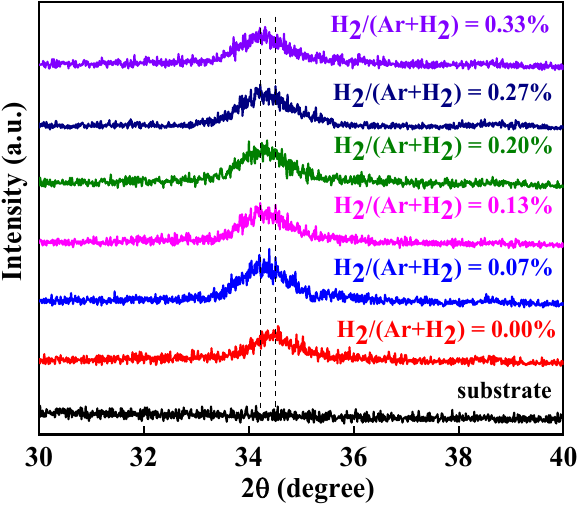
Figure 3. GIXRD curves of ZnO:H/ZnO films prepared with different H 2 /(Ar + H 2 ). To analyze the effect of H doping on oxygen-related defects in ZnO films, the O 1s energy spectra of ZnO:H films with different H 2 /(Ar + H 2 ) were obtained by XPS measurement and are shown in Figure 4. The O 1s energy spectra were calibrated by using 285 eV C 1s binding energy as the standard in order to compare the measured O 1s binding energy with the data from the NIST database and other references. As exhibited in Figure 4a–f, the fitting results consist of three components of oxygen in varying chemical states [24–27]. The fitting peak at 529.8 ± 0.2 eV is related to the O 2 − in metal oxide, representing the lattice oxygen existing in the Zn-O bonds, marked as O 1 . The fitting peak at 530.7 ± 0.2 eV is associated with O 2 − ions in the oxygen-deficient regions within the matrix of ZnO, and the peak intensity reflects the change of oxygen vacancy (V O ) content, marked as O 2 . The fitting peak at 531.9 ± 0.2 eV is attributed to the loosely bound oxygen in ZnO, including oxygen interstitials (O i ) and adsorbed oxygen [28], marked as O 3 . From the integrated intensities of three fitting peaks, the proportion of three oxygen components can be obtained according to Equation (1).